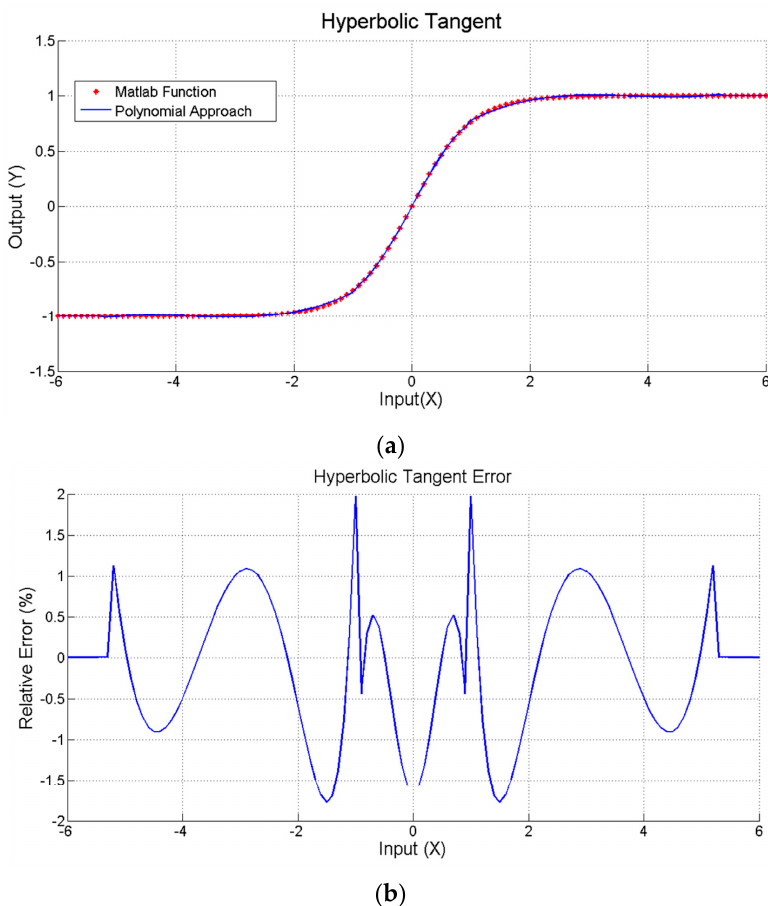
Figure 13. ( a ) Hyperbolic tangent computation using a standard C library tanh(x) function (red) and the piecewise approach (blue) on a microcontroller; ( b ) Relative error of the polynomial fitting compared to the library function.